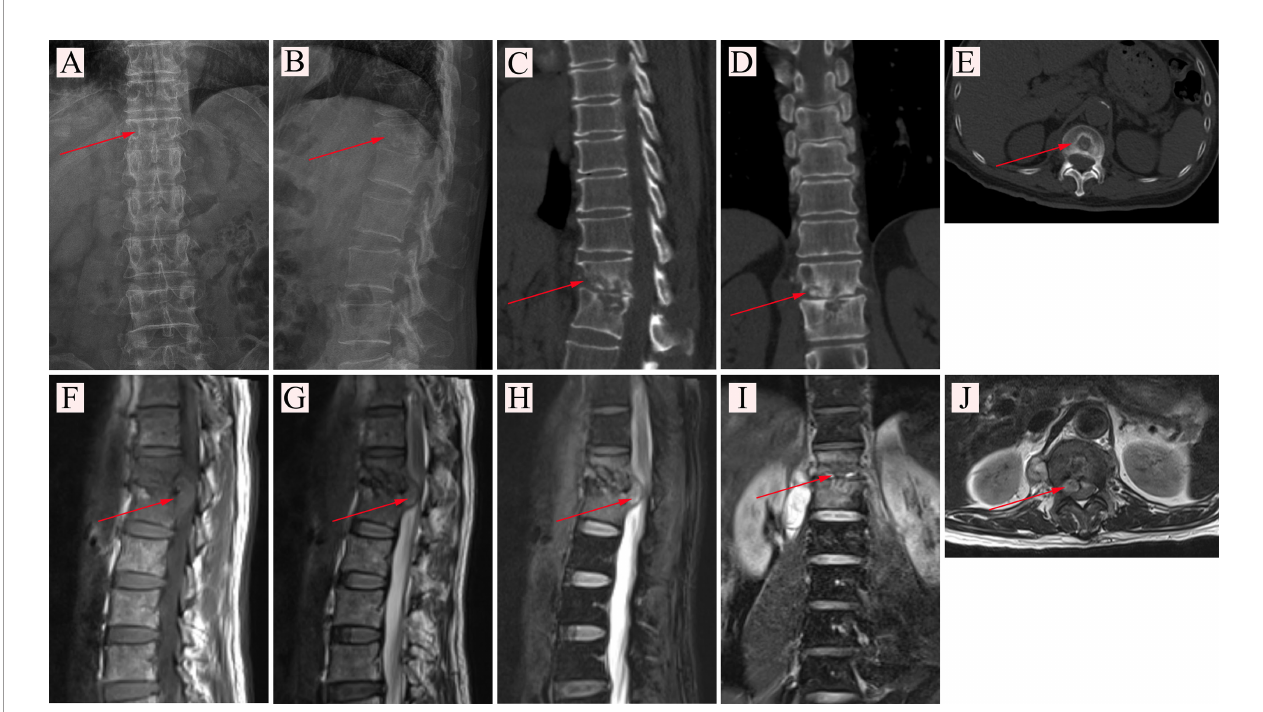
FIGURE 1 | (A, B) X-ray examination of a patient with spinal tuberculosis. The arrow points to the location of the lesion. (A) X-ray image in posterior-anterior position. (B) X-ray image in lateral position. (C – E) CT examination of a patient with spinal tuberculosis. The arrow points to the location of the lesion. (C) CT image in sagittal position. (D) CT image in coronal position. (E) CT image in cross-section. (F – J) MRI examination of a patient with spinal tuberculosis. The arrow points to the location of the abscess. (F) MRI image in the sagittal T1 sequence. (G) MRI image in the sagittal T2 sequence. (H) MRI image of T2 lipid compression sequence in sagittal position. (I) MRI image in coronal position. (J) MRI image in cross-section.